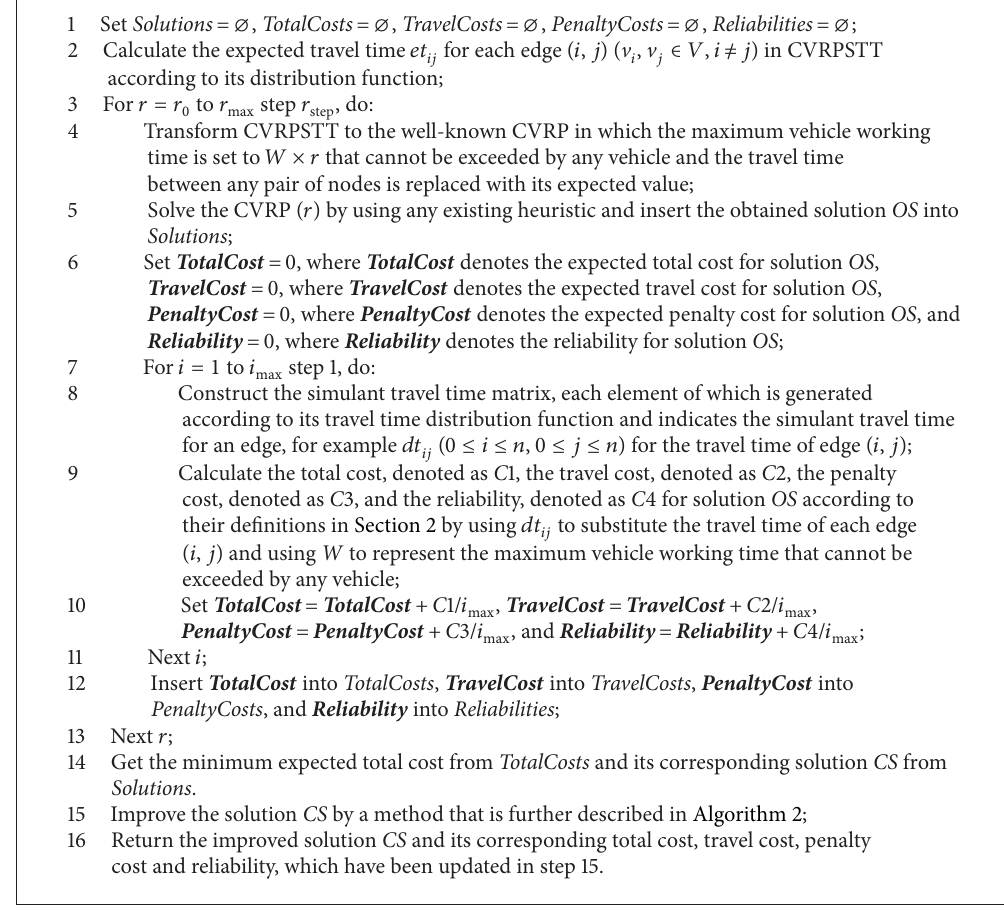
Algorithm 1: The suggested algorithm of the